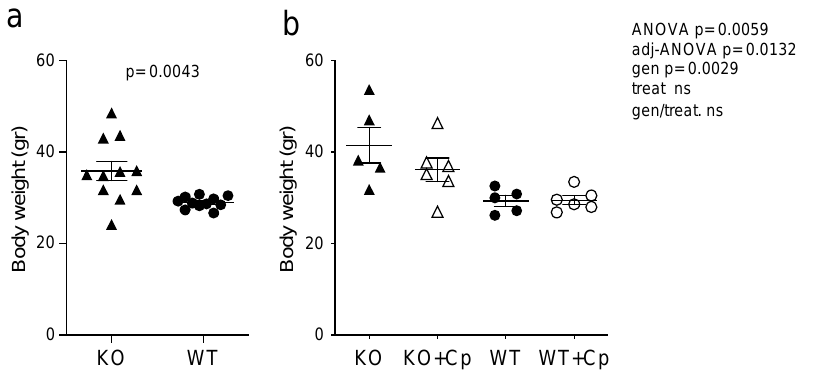
Figure 1. CpKO mice are overweight and Cp administration partially prevents body weight increase. ( a ) Body weight of mice at 8 months of age before the treatment (CpKO and WT, n = 11). ( b ) Body weight of mice at 10 months of age after 2 months of treatment with intraperitoneal injection of Cp 5 μg/g , administered every 5 days (KO+Cp and WT+Cp, n = 6) or saline (KO and WT, n = 5). Data are presented as mean ± SEM of animal groups, each dot corresponds to one mouse. Statistical p values were evaluated by Student’s t -test in ( a ) and by two-ways ANOVA in ( b ); the latter are reported as value for overall ANOVA, value for Benjamini-Hochberg adjustment for multiple ANOVA tests related to liver features (adj-ANOVA), for genotype variable (gen), for treatment variable (treat) and for the interaction of genotype/treatment (gen/treat). CpKO Mice the liver and perigonadal adipose tissue (pgAT) of CpKO mice (Figure 2a,b). In mouse